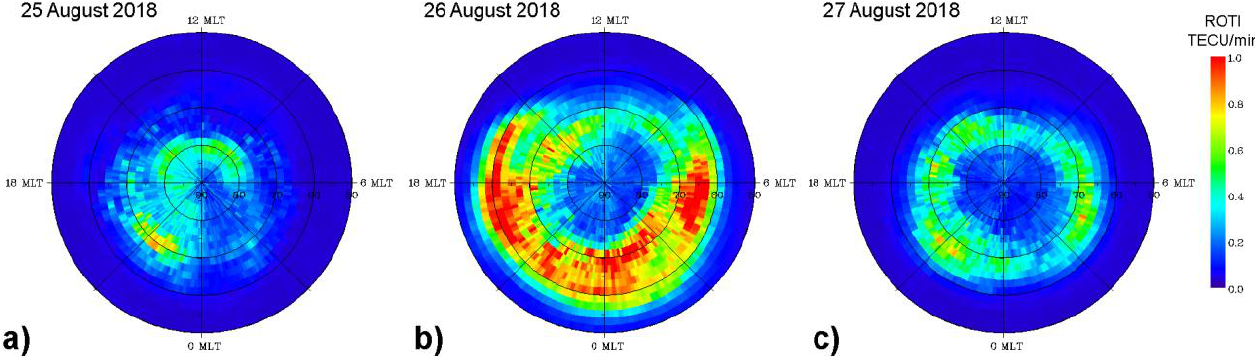
Figure 3. Daily MLT-MLAT ROTI maps for the Northern Hemisphere for ( a ) 25 August, ( b ) 26 August, and ( c ) 27 August 2018. The maps cover 50°–90° N MLAT with 10° latitude circles; magnetic local noon/midnight is at the top/bottom, and dusk/dawn is toward the left/right. Blue color corresponds to the absence or very weak ionospheric irregularities, red color—severe ionospheric irregularities occurrence.